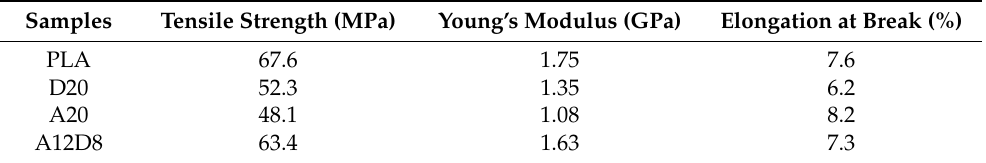
Table 3. Tensile properties of PLA and its composites.